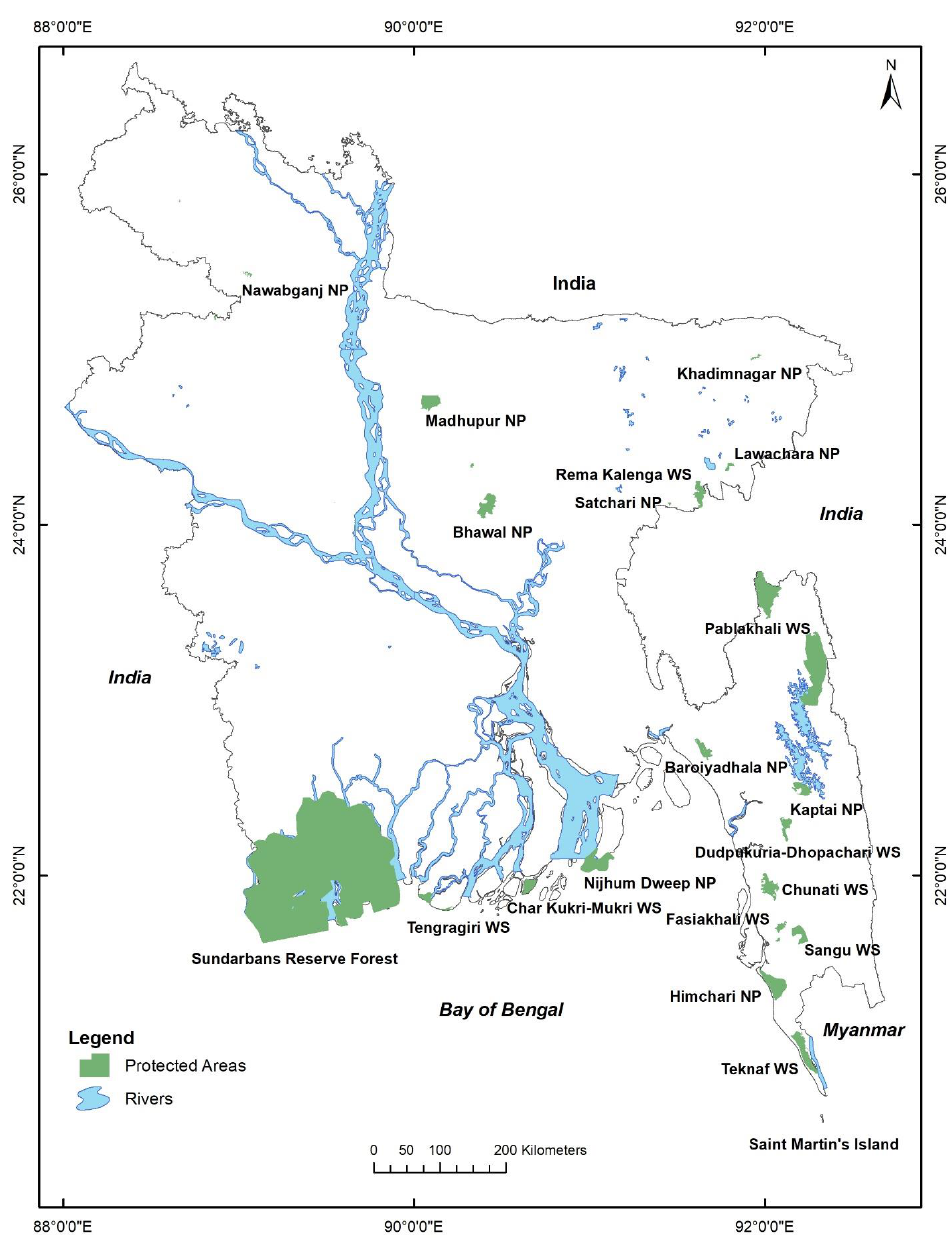
Figure 2. Protected Areas in Bangladesh - priority sites for bat diversity surveys, here NP = National Parks, and WS = Wildlife Sanctuary.